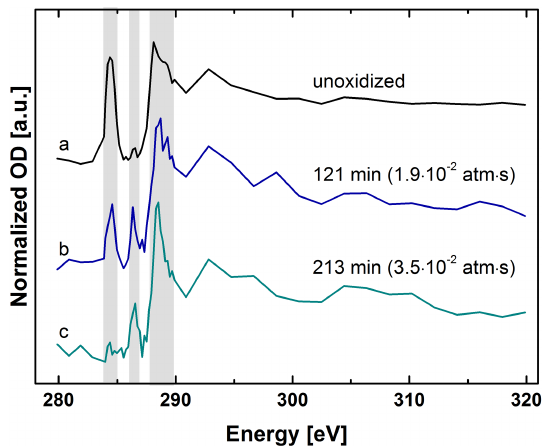
Figure 2. Averaged spectra of single particles before and after oxi- dation at a relative humidity of 82%. The grey areas denote regions in which spectral changes can be observed. The main feature of the oxidation is the decrease of the 1s- π ∗ peak at